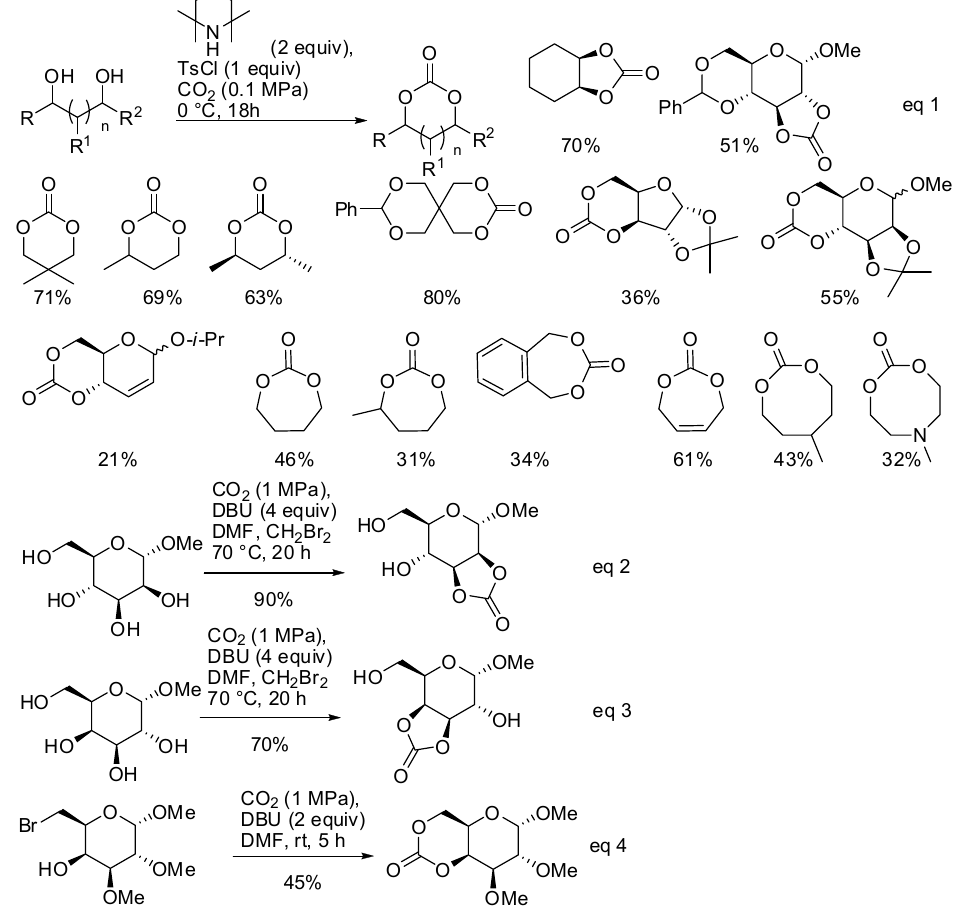
Scheme 12. Synthesis of 5-, 6-, 7- and 8-membered cyclic